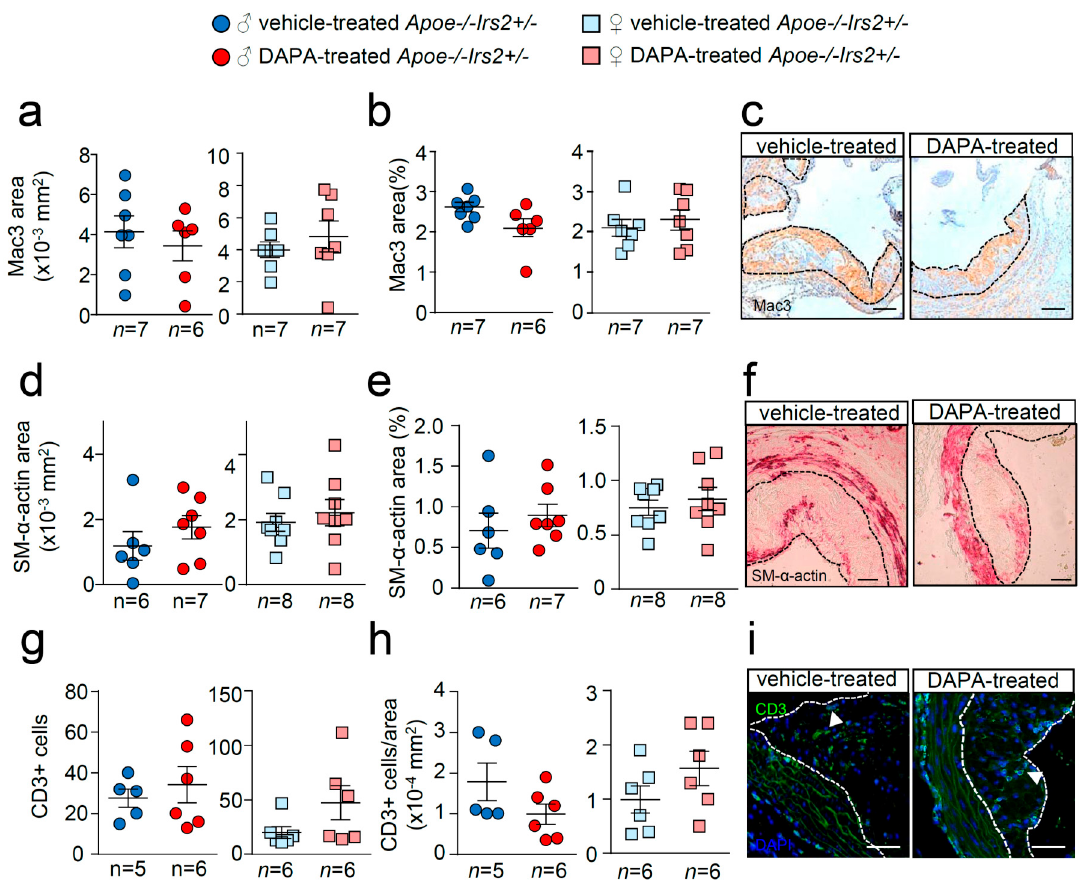
Figure 5. E ff ect of DAPA in atheroma plaque characteristics of Apoe − / − Irs2 +/ − mice. ( a , b ) Macrophage and ( d , e ) vascular smooth muscle cell (VSMC) content in aortic cross-sections from vehicle- and DAPA-treated male (left panels) and female mice (right panels), determined as Mac3 + and SM- α -actin + areas measured as absolute area (in mm 2 ) ( a , d ) and as percentage of the positive-stained area relative to lesion area ( b , e ). Scale bar: 100 µ m. Number of T lymphocytes in lesions of aortic cross-sections detected as CD3 + cells and depicted as ( g ) absolute cell number and as ( h ) cell number relative to lesion area (in mm 2 ) in both sexes from vehicle- and DAPA-treated mice. Scale bar: 50 µ m. Photomicrographs next to the quantifications ( c , f , i ) show representative images of the immunostainings. White arrows in ( i ) point to CD3 + cells. The limits of the lesion are indicated by the dashed lines. The statistical analysis for normal distribution was the D’Agostino–Pearson omnibus test ( d , e ) and Kormokov–Smirnov was performed using Student’s t -test ( d , e . right panels) and Mann–Whitney U test ( a , b , g , h ) and ( d , e , left panels).